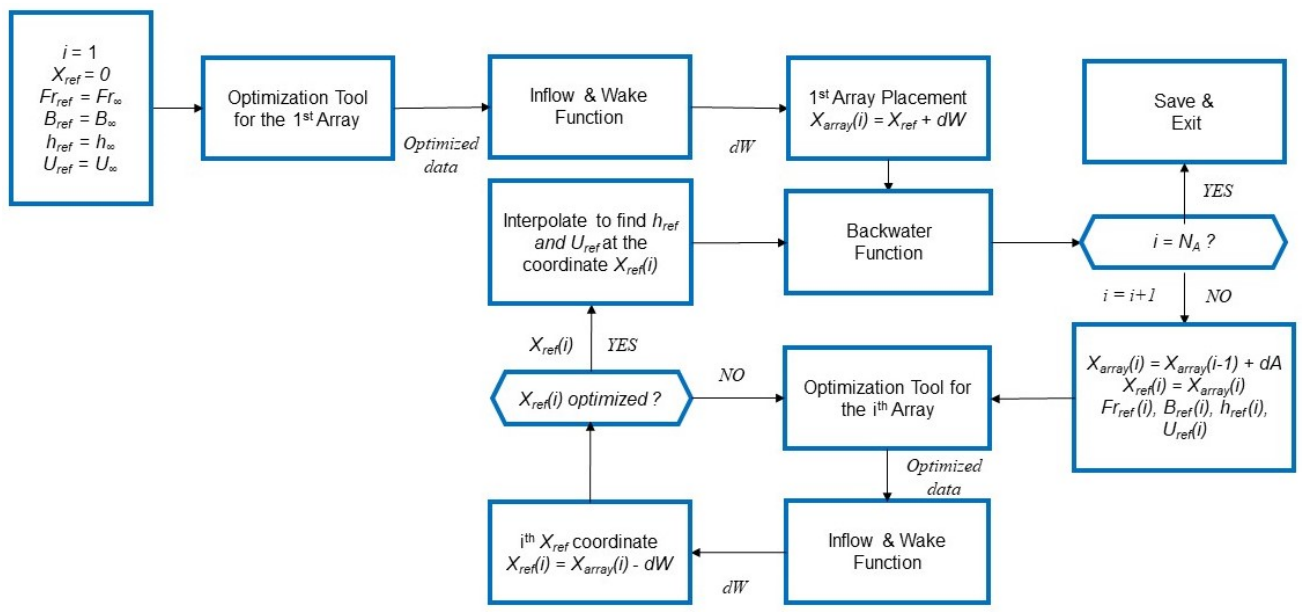
Figure 8. Flowchart for solving DMS applied to an array of HK turbines.